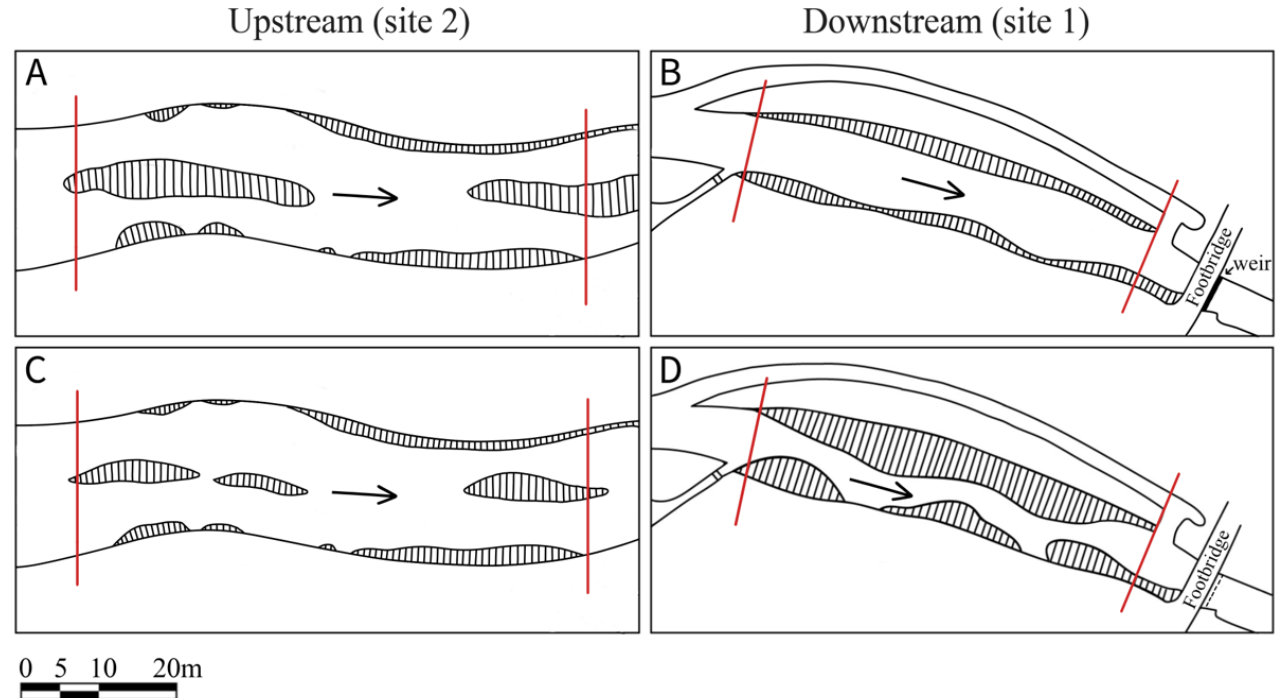
Figure 3. Control (site 2) and Impact (site 1) before ( A , B , 2013) and after restoration ( C , D , 2018). Red lines indicate extent of surveyed stretch. Hatching indicates bank and instream features (e.g., plant growth and gravel bars). Arrows represent direction of water flow.